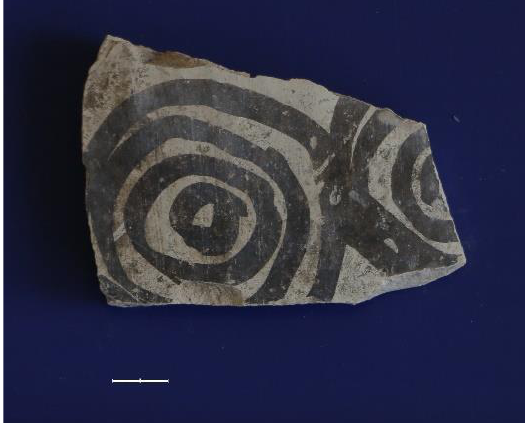
Figure 26- A broken piece of pottery with the plant